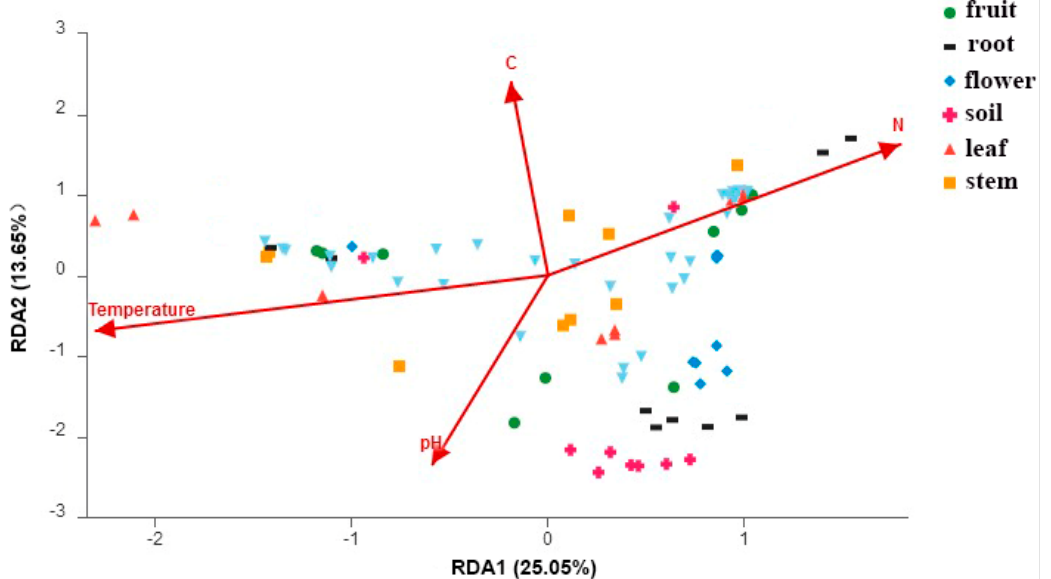
Figure 5. RDA plot showing the correlation between fungal community structure and soil properties.